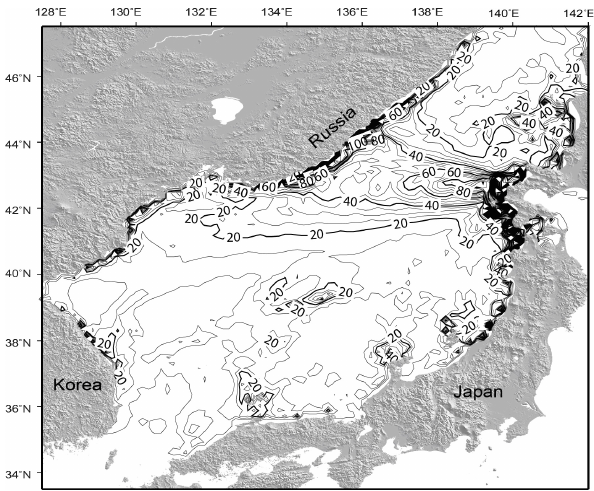
Fig. 4. The distribution of maximum wave heights (cm) in the East (Japan) Sea for the 1993 tsunami.